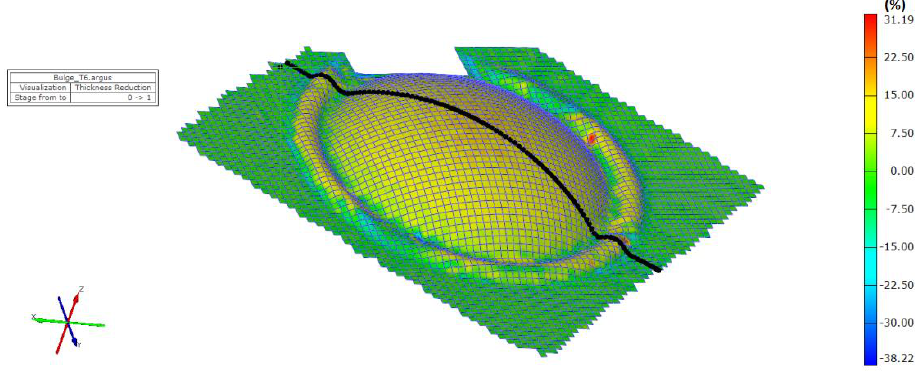
Figure 11. Material thinning after bulge test of T3 sample evaluated by ARGUS system.